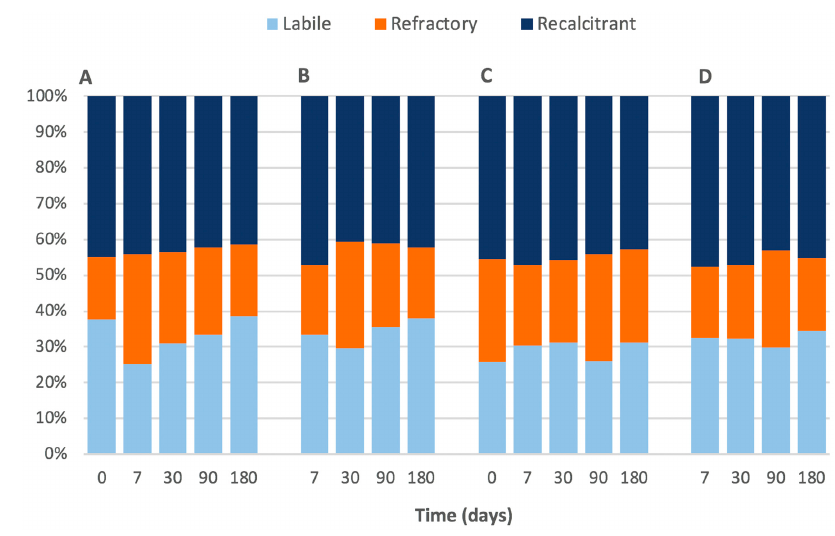
Figure 2. Thermogravimetric analysis (TGA) showing the labile, refractory, and recalcitrant percentages of organic carbon in the 0–0.5 cm portion of ( A ) procedural control and ( B ) high treatment, and the 8–10 cm portion of ( C ) procedural control and ( D ) high treatment. Diversity 2018 , 10 , x FOR PEER REVIEW